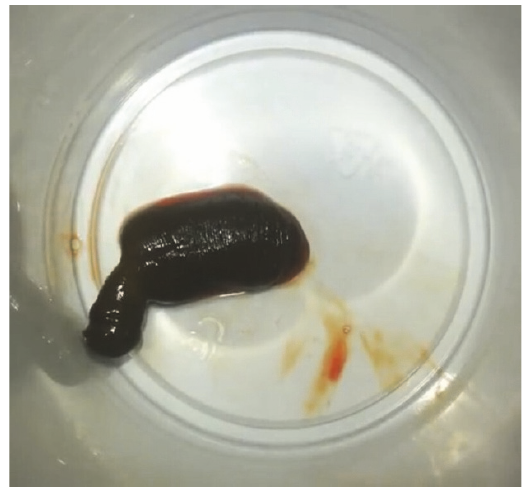
Figure 1: Live leech after its vulva